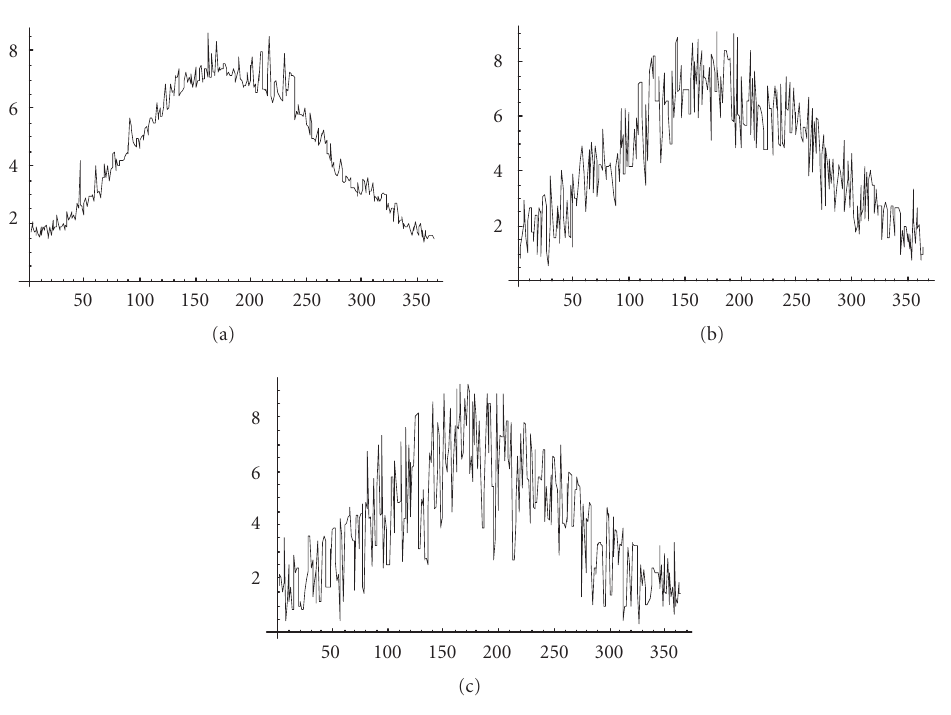
Figure 7: Yearly solar radiation (kWh) for (a) 0 . 2 σ , (b) σ , and (c) 2 σ standard deviation for the city of